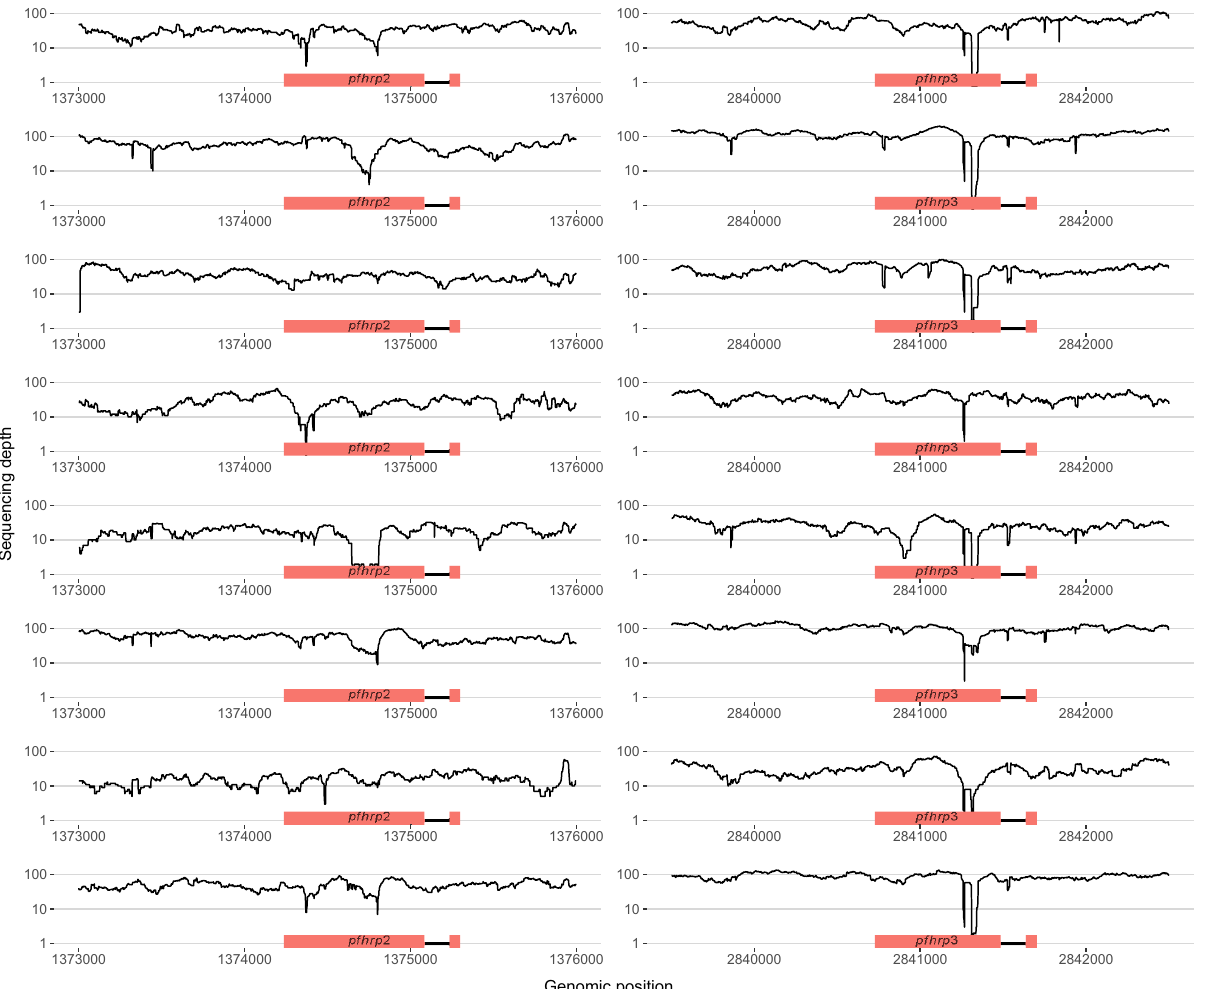
Figure 4. No pfhrp2 or pfhrp3 deletions were identified by whole-genome sequencing. WGS of five pfhrp2−/3−, two pfhrp2−/3 + , and one pfhrp2 + /3− parasites originally identified by PCR confirmed intact genes. Each row represents a distinct sample: from SANHRP_01 (top) to SANHRP_08 (bottom). Depth of coverage statistics and sample characteristics are provided in Supplementary Fig. 2 and Supplementary Tables 2–3.